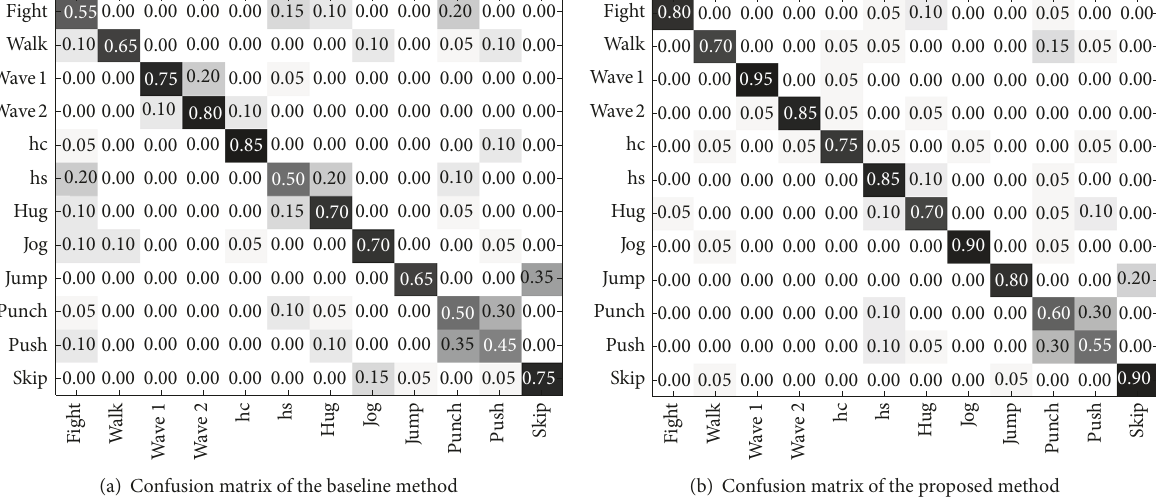
Figure 8: The comparison of the confusion matrices between the baseline method and the proposed method in InfAR dataset, where the left is from the baseline method, while the right is from our proposed CDFAG. Note that “hc” denotes “handclapping” and “hs” denotes “handshaking,”